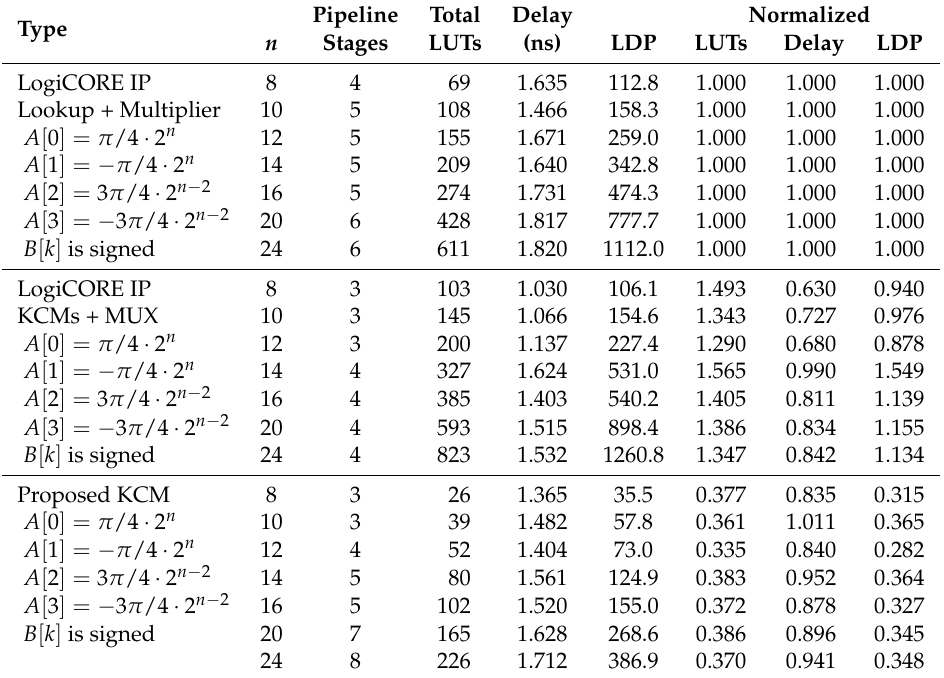
Table 10. Synthesis results for pipelined ( m × n )-bit KCMs with four selectable coefficients where m = n , A [ k ] = ± π /4 · 2 n or ± 3 π /4 · 2 n − 2 and all B [ k ] are signed variables. Proposed units use 63% fewer LUTs on average compared to LogiCORE IP multiplier-based units and 74% fewer LUTs on average compared to LogiCORE IP KCM-based